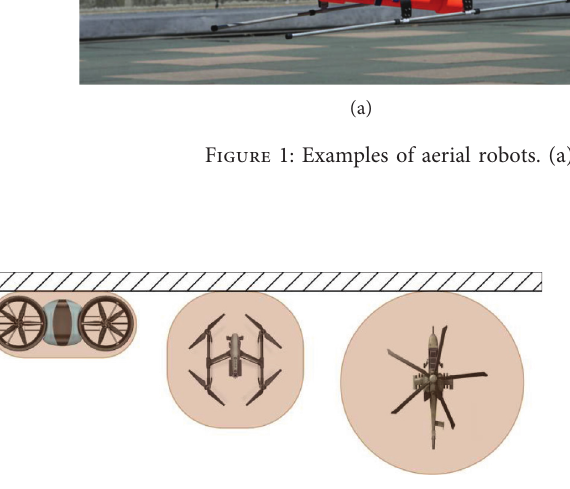
Figure 2: Comparison of flight area requirements of different types of aerial robots.